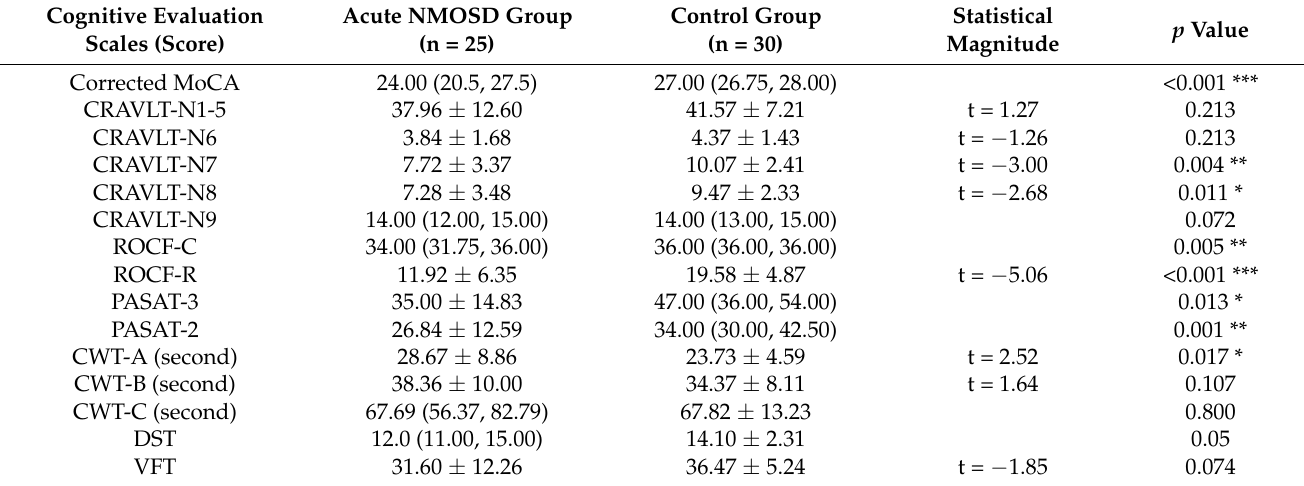
Table 2. Comparison of cognitive evaluation scales between acute NMOSD and control